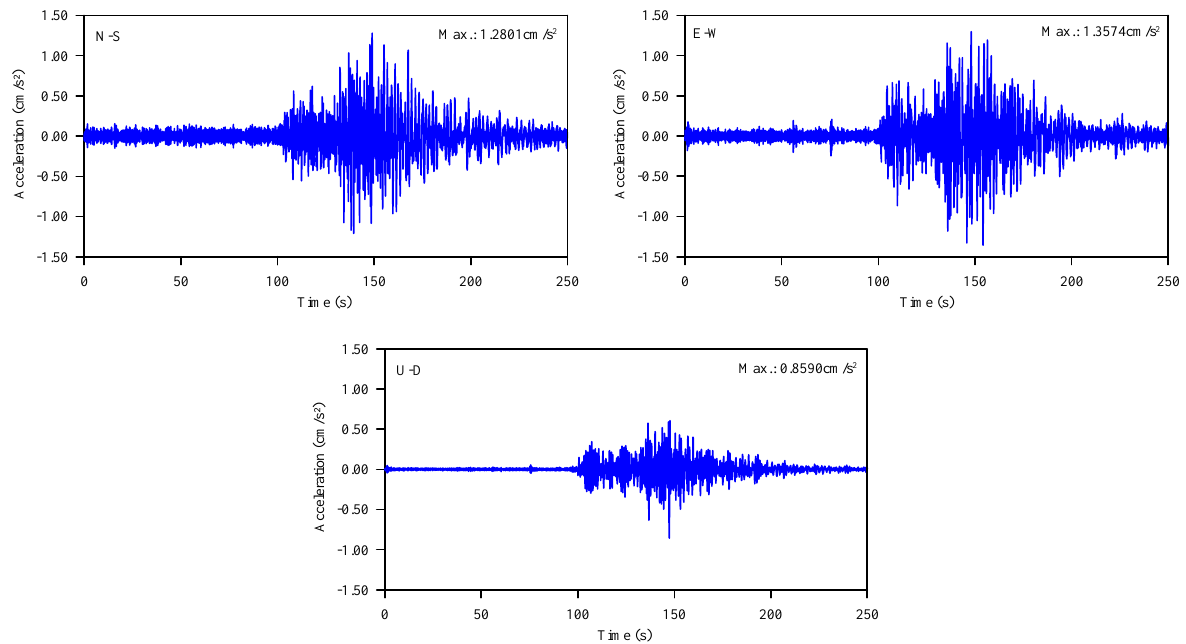
Fig. 5 Acceleration records of Bala (Ankara) Earthquake on December 27, 2007.